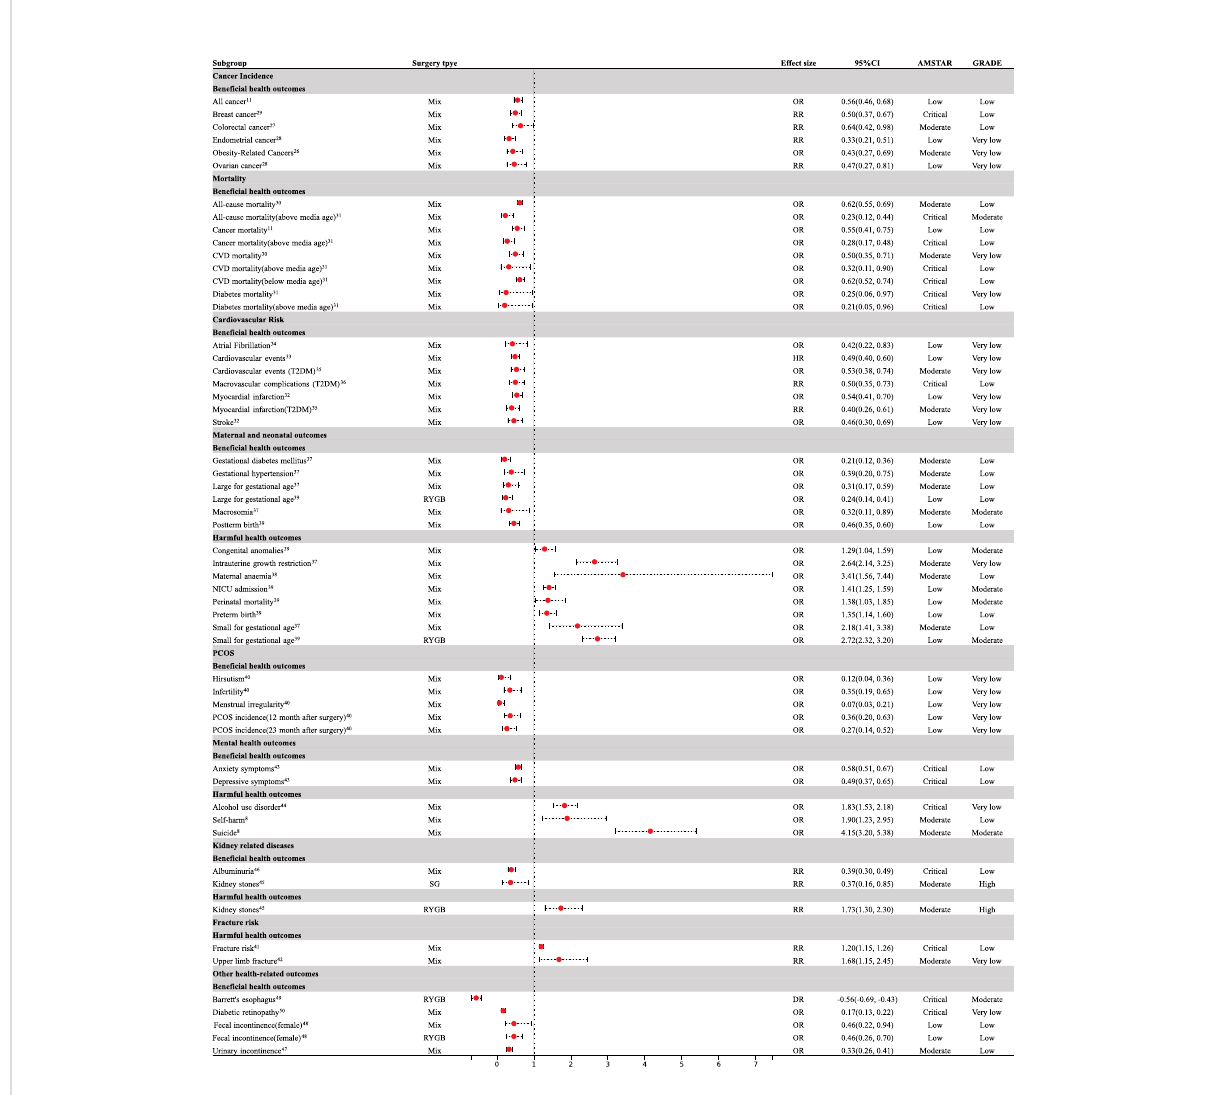
FIGURE 3 Forest plot of bene fi cial and harmful health outcomes associated with bariatric surgery. CI, con fi dence interval; CVD, cardiovascular disease; T2DM, type 2 diabetes mellitus; PCOS, polycystic ovary syndrome; RYGB, Roux-en-Y gastric bypass; SG, Sleeve Gastrectomy; NICU, neonatal intensive care